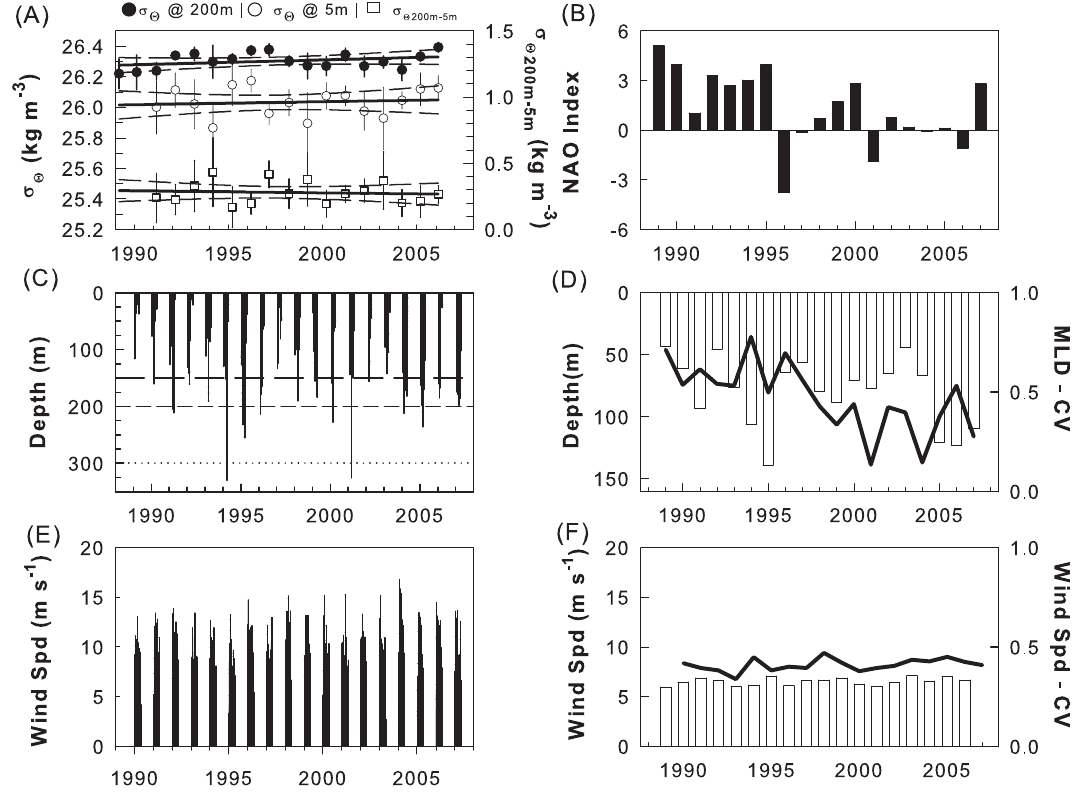
Fig. 6. Time-series of upper ocean physical forcing at BATS. (a) Mean ( ± std. dev.) σ θ (kgm − 3 ) for near surface water ( ∼ 5m; open circles) and 200m (filled circles), and the difference between the two (open squares). Solid lines are the least square Model 1 linear regression and dashed lines are the 95% confidence intervals. (b) winter (December through March) index of the NAO. (c) Estimated mixed layer depths using a variable σ T difference criterion of 0.02kgm − 3 difference from the surface ( ∼ 5m) value. Horizontal lines denote the depths of the BATS sediment traps at 150, 200 and 300m. (d) Mean mixed layer depth (bars) and the coefficient of variation within each winter (solid line). (e) daily winter/spring wind speeds recorded at the Bermuda Airport. (e) Same as (c) but for wind